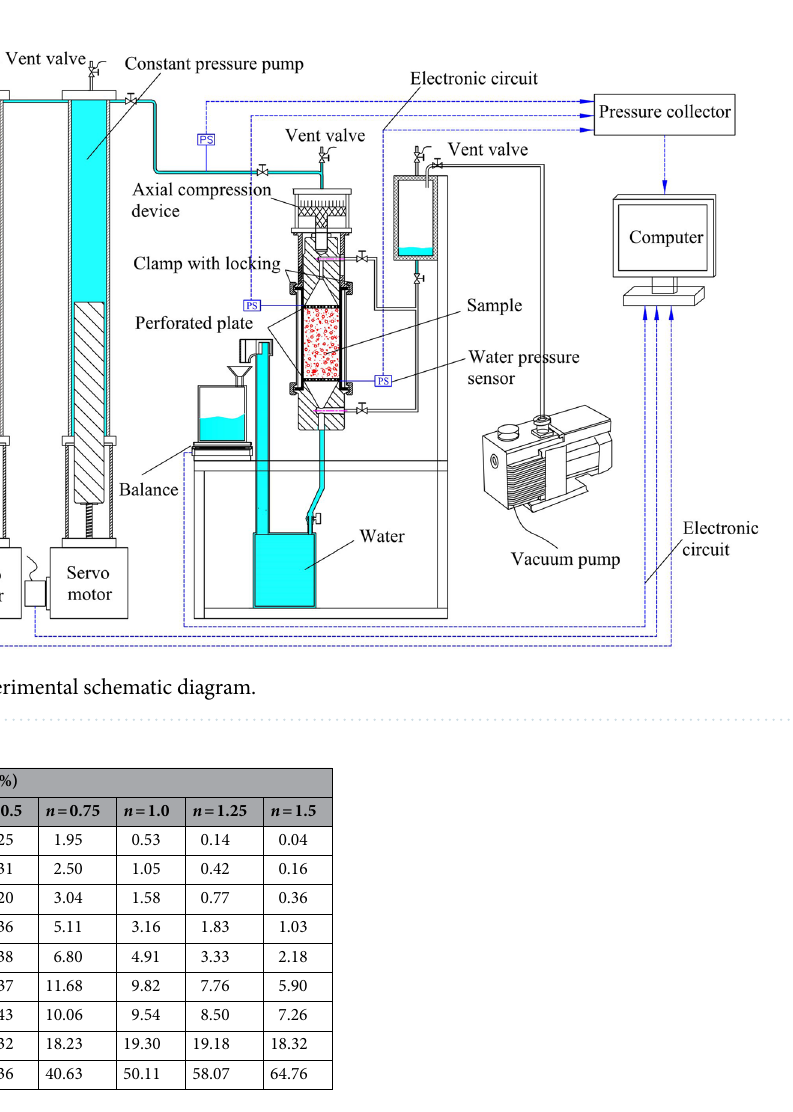
Table 1. Grain size distributions of